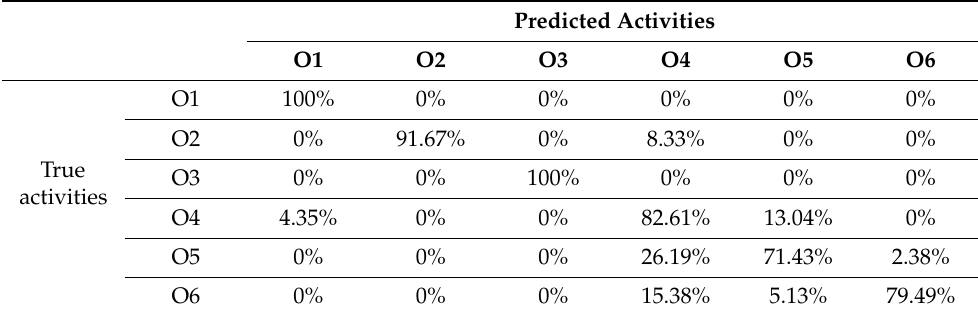
Table 3. The confusion matrix of six activities: stationary (O1), ascending (O2), descending (O3), normal walking (O4), lateral walking (O5), and stationary stepping